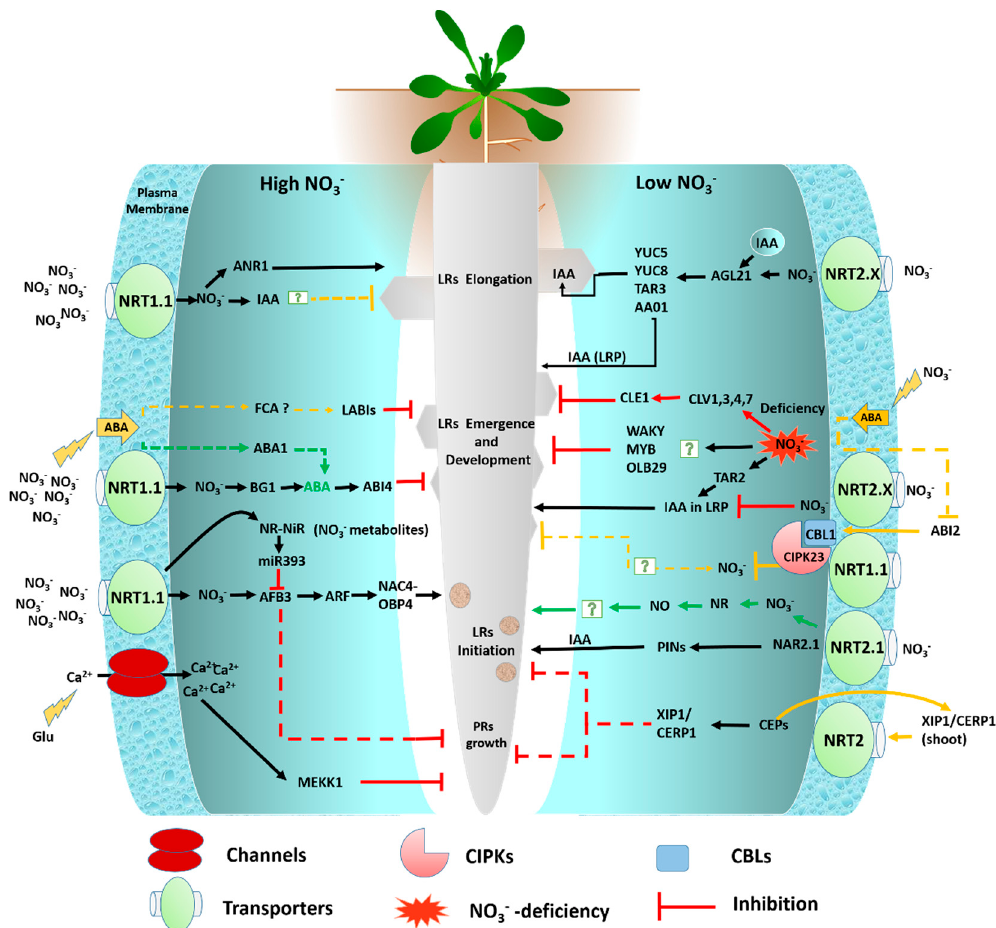
Figure 3. The schematic diagram presents the multiple pathways regulating the root system architecture (RSA; lateral and primary root) response to the localized and high nitrate conditions in Arabidopsis . Only those pathways discussed in the present review are depicted. The green arrows indicate systemic transport and assimilation, the black arrows indicate positive signaling as a stimulatory e ff ect, red lines indicate negative signaling as an inhibitory e ff ect, the orange lines depict the unknown positive and negative signaling pathways, and dotted lines represent the unconfirmed nitrate-mediated signaling pathways. The low nitrate and severely low nitrate conditions have been reported to have a stimulatory and inhibitory e ff ect on LR development, respectively, while high NO 3 − supply has an inhibitory e ff ect on LR growth [24] (see text for further information). External NO 3 regulates primary root growth in Arabidopsis . The receptor for the external glutamate signal is shown as a glutamate-gated Ca 2 + channel because these are known to be activated at root tips [79]. However, its specific role in this signaling pathway is unconfirmed (see text for further